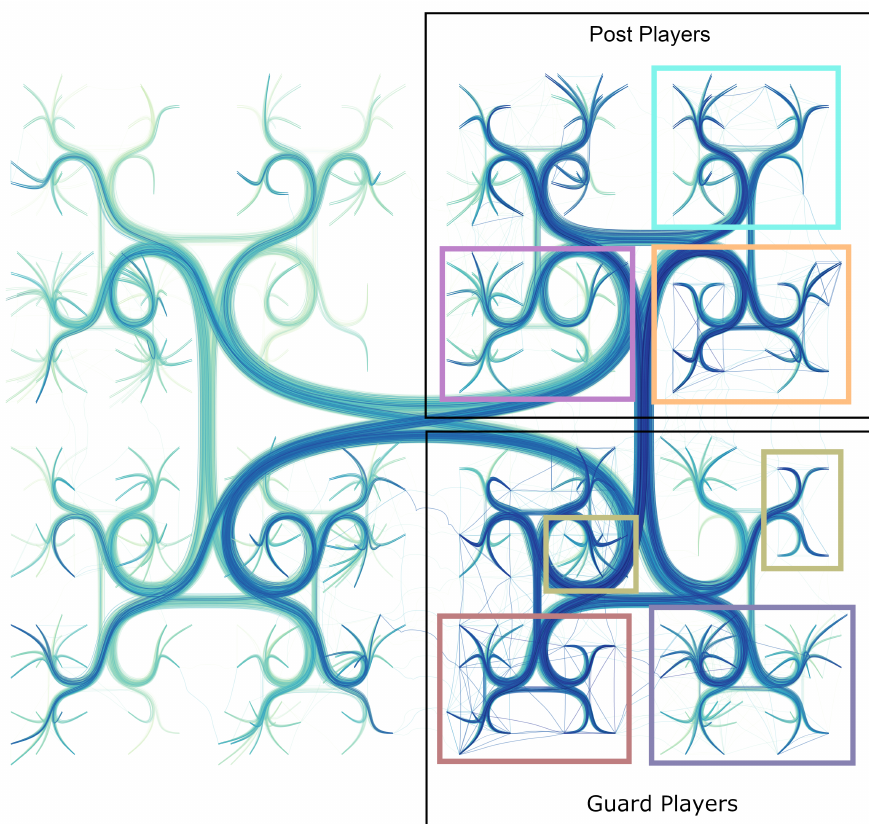
Figure 14. SDEB layout of the #NBABallot dataset. Different voting patterns can be observed including connections linking similar